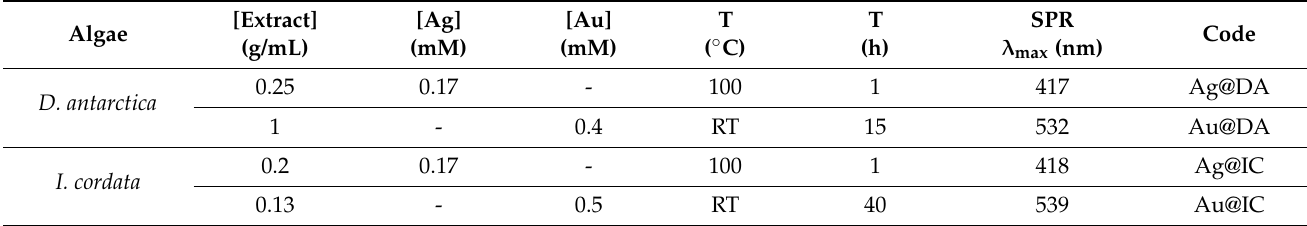
Figure 1. ( a ) UV-Visible spectrum of AuNP synthesized with a fixed concentration of Desmarestia antarctica (DA) and different concentrations of HAuCl 4. ( b – e ) UV-Visible spectra of the synthesis of AgNP with different concentrations of DA extract and AgNO 3 . The final optimal reaction conditions are shown in Table 1, while Figure 2a,b show the corresponding UV-Vis spectra. Table 1. Optimal reaction conditions for gold and silver nanoparticles